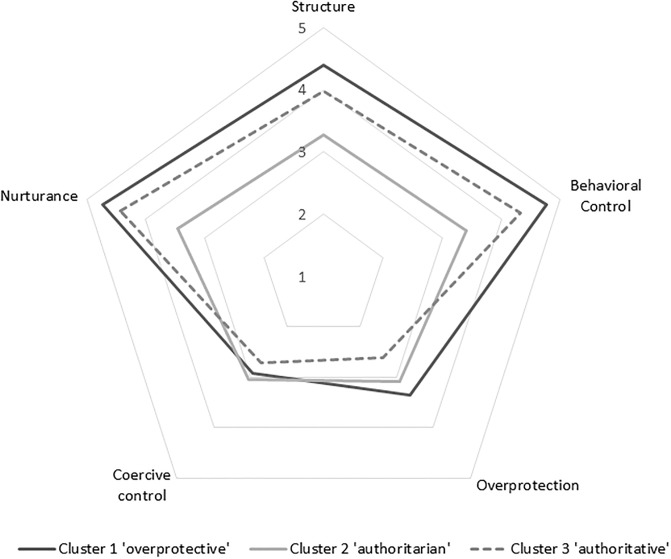
Representation of the three clusters for the main constructs of parenting stylea.a Mean scores (standard deviation) on the main constructs for the 3 clusters (cluster 1 = C1, cluster 2 = C2, cluster 3 = C3) were as follows: Structure: C1 = 4.39 (0.30) C2 = 3.28 (0.28) C3 = 3.97 (0.33); Behavioral Control: C1 = 4.76 (0.22), C2 = 3.41 (0.41), C3 = 4.32 (.31); Overprotection: C1 = 3.36 (.57), C2 = 3.08 (.43), C3 = 2.61 (.62); Coercive control: C1 = 2.93 (.72), C2 = 3.05 (.43), C3 = 2.71 (.62); Nurturance: C1 = 4.73 (.19), C2 = 3.47 (.37), C3 = 4.43 (.29).